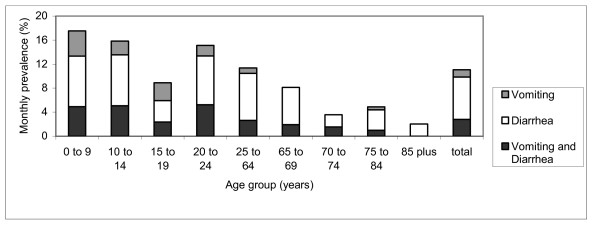
Monthly prevalence of acute gastrointestinal illness by age group and primary symptom, in the province of British Columbia, Canada.